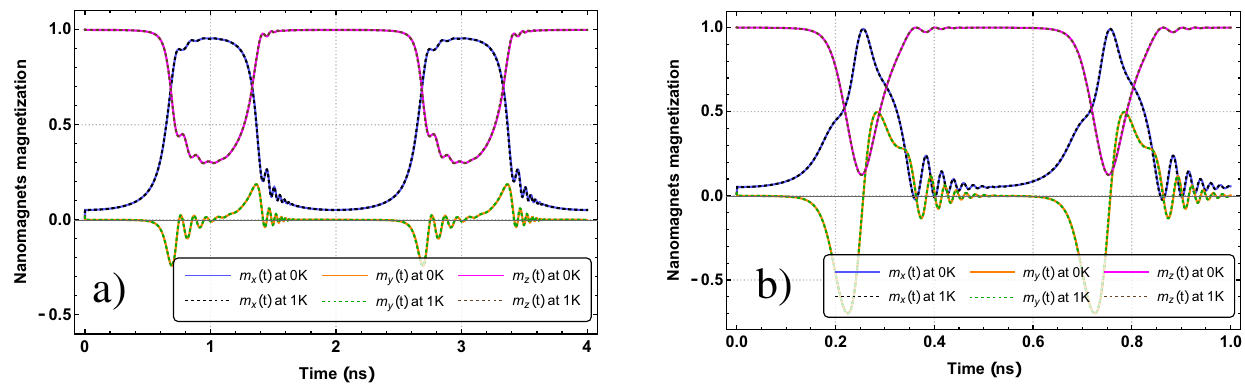
Fig. 7 Effect of thermal noise on the nanomagnets. Magnetization of the nanomagnet at 0 K and 1 K, a drived at 500 MHz and b